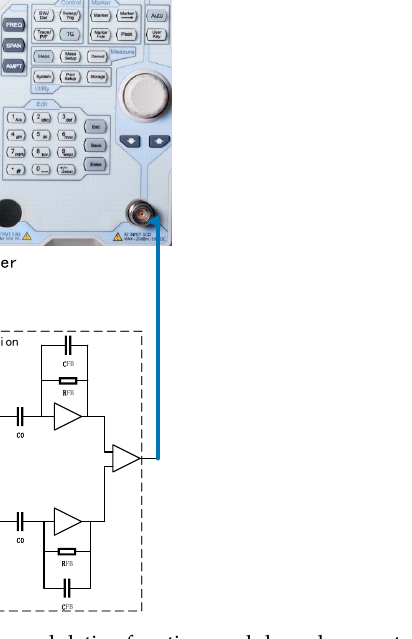
Figure 17. Capacitive sensing system demodulation function module under zero ‐ tolerance measurement.